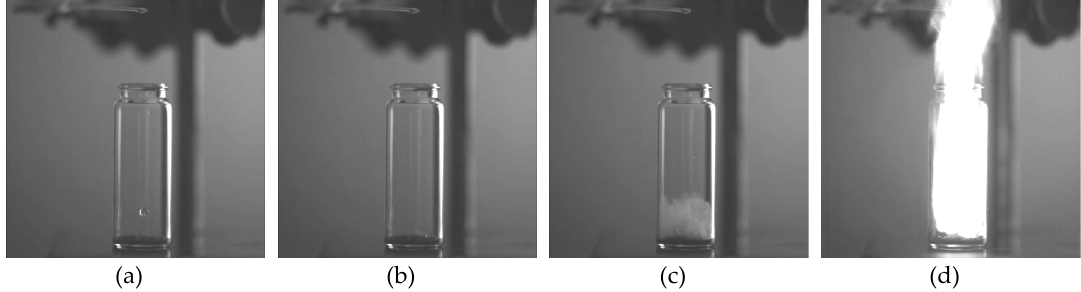
Figure 22. Hypergolic reaction of a gel fuel with high-test hydrogen peroxide (HTP) (sequence from high-speed video recording, courtesy of M. Kurilov). ( a ): falling HTP droplet; ( b ): contact of HTP droplet with gel fuel; ( c ): mixing/evaporation (approx. 10 ms after contact); ( d ): ignition (approx. 12–15 ms after contact).